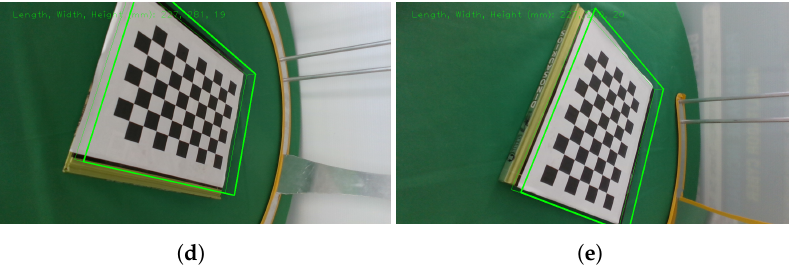
Figure 6. Calibration setup and the view from all 5 cameras ( a – e ). All sensors look at a common checkerboard serving as the calibration item. The green box displays the dimensions of the book underneath the checkerboard to validate that the process was completed successfully. This shows the simultaneous view of the calibration